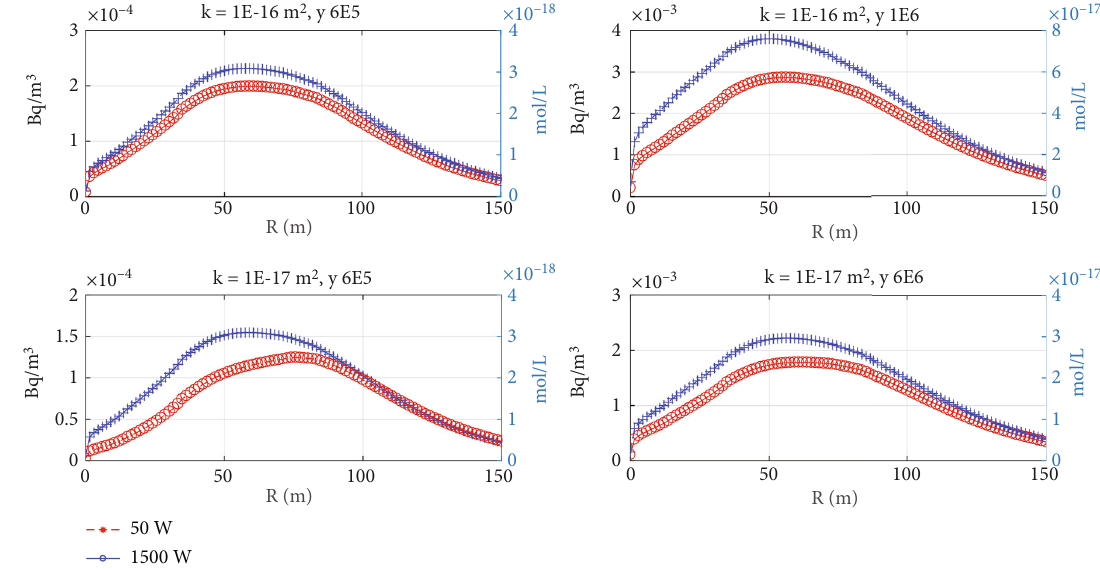
Figure 12: Longitudinal pro fi les of 99 Tc activity concentration and annual dose at the hypothetical well depth ( Z = − 60 m ) along radial distance R for k = 10 − 16 m 2 (a, b) and k = 10 − 17 m 2 (c, d) considering 50 Watt (red) and 1500 Watt (blue) for the 500m deep